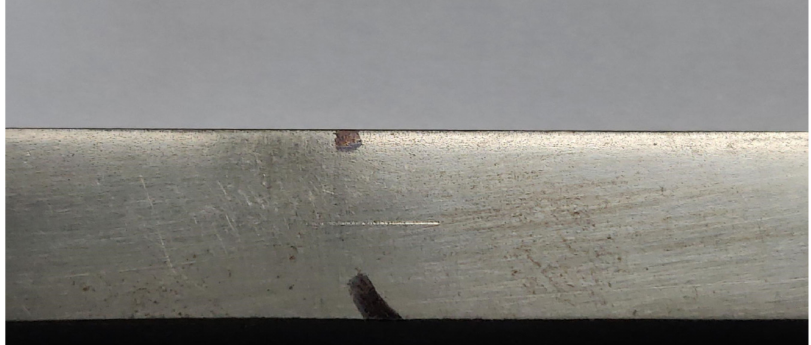
Figure 7. Photograph of the non-phosphate nodular cast iron specimen after the scratch test. The hardening and agglomeration of the material have the effect of increasing the COF exponentially up to 0.64, which is achieved after 8 mm.